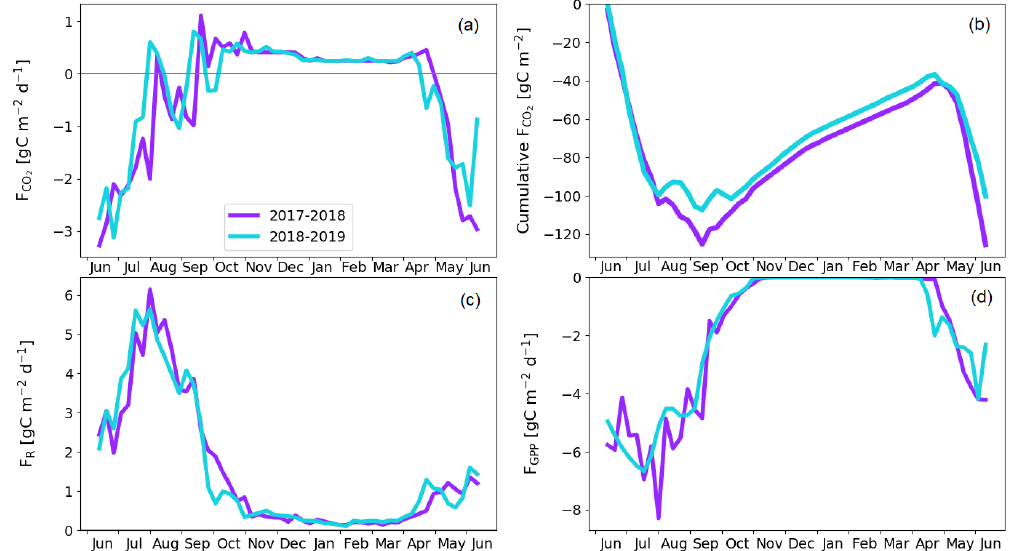
Figure 8. Pine forest gap-filled fluxes. Weekly averaged (a) and cumulative (b) CO 2 flux. Weekly averaged ecosystem respiration (c) and gross primary productivity (d) .